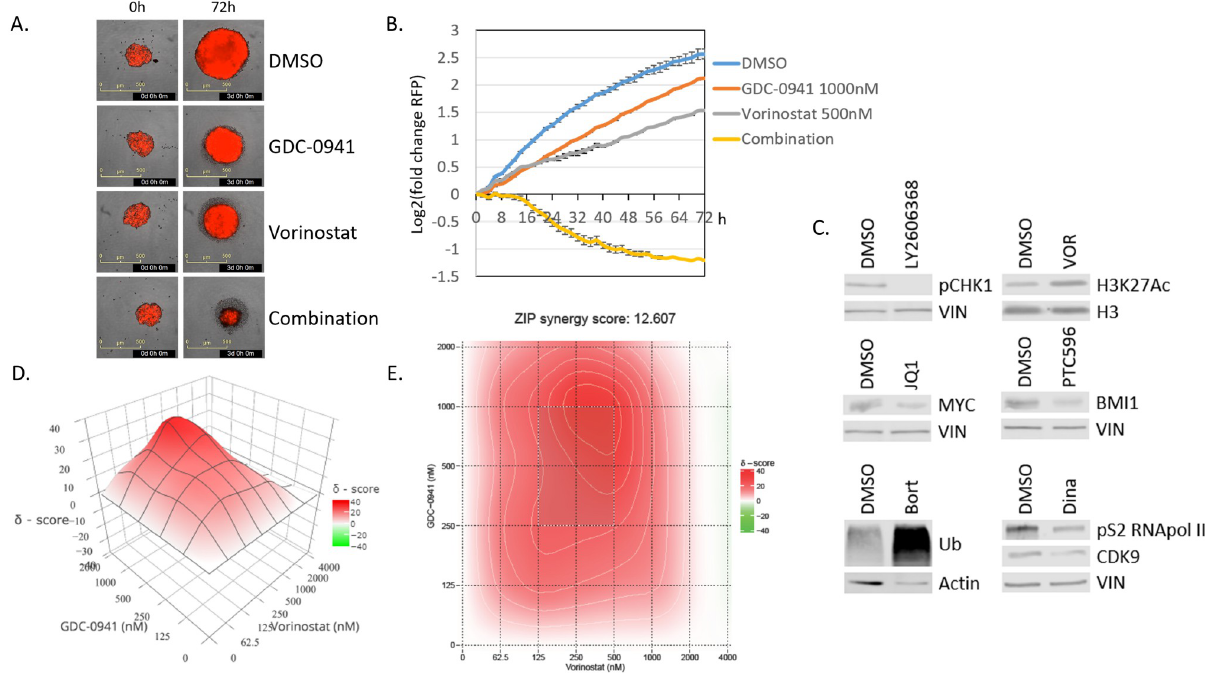
Fig 3. Sensitivity to combination therapies. (A) Representative images of glioma line 5746 treated with GDC-0941 (1000nM), Vorinostat (500nM) or a combination. Images on the left show size and red intensity of the sphere at the starting point of the assay (0h). Images on the right show the same sphere at 72h. Combination of GDC-0941 and Vorinostat causes potent cell death. (B) Growth curves of 5746 treated with GDC-0941 and/or Vorinostat for 72h. Error bars denote the standard deviation. A log2(fold change) of -1 denotes 50% lower signal compared to starting point. (C) Western blot confirming the target inhibition of our compounds. An increase in ubiquitinated proteins is shown by treatment of cell line 17 with 5nM bortezomib; pCHEK1 is inhibited with 100nM LY2606368; MYC [33] is inhibited by the BRD4 inhibitor JQ1 (500nM); BMI1 [34] is downregulated by treatment with 500nM PTC596; H3K27Ac is upregulated by treatment with 1 μ M Vorinostat and expression of CDK9 [35] and its substrate pS2 RNApol II is reduced with 25nM Dinaciclib. (D) 3D graphical representation of the synergy score as determined by synergy finder. X-axis: GDC-0941 concentration, Y-axis Vorinostat concentration, Z-axis synergy score ( δ ). (E) 2D heatmap representing the same synergy score data